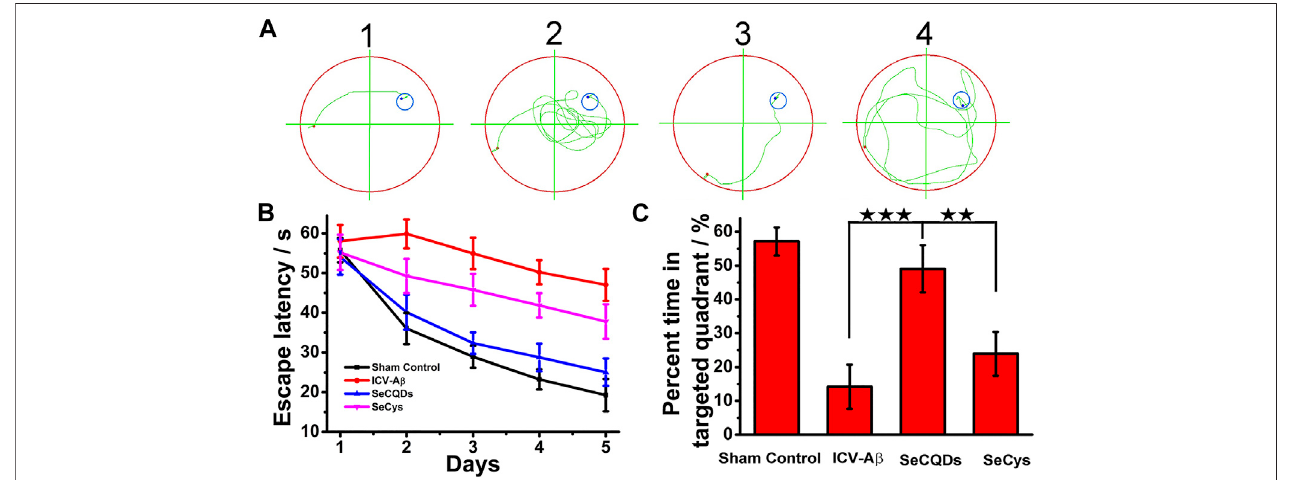
FIGURE 8 | The effect of SeCQDs on the cognitive functions of the rats induced by A β via the Morris water maze test. The swimming trace to fi nd the hidden platform (A) . The escape latency to fi nd the hidden platform during the 5-days training (B) . The percent time spent in the target quadrant after 5 days training (C) . Data represents mean ± SEM. * p < 0.05, ** p < 0.01, *** p < 0.001.